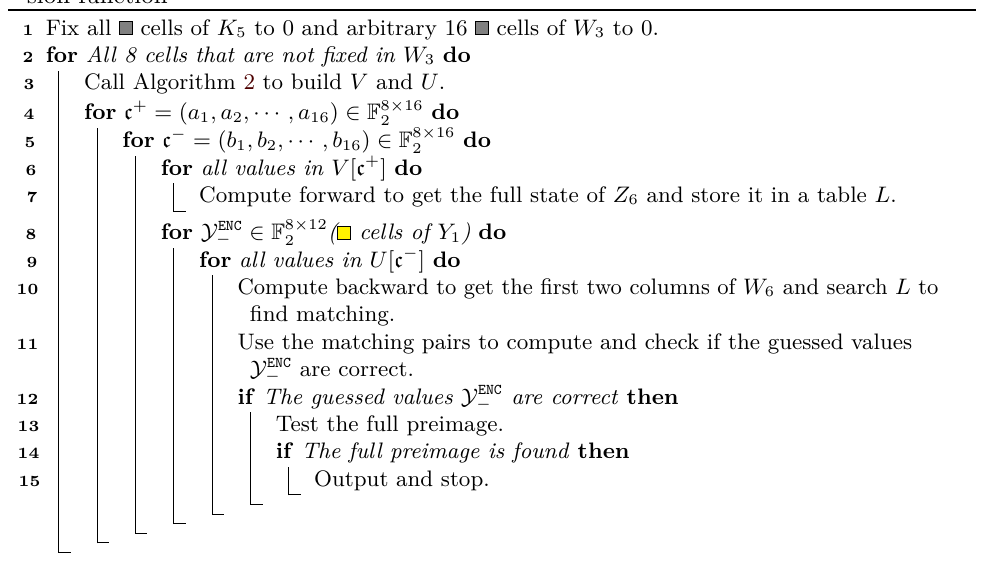
Algorithm 4: The MITM preimage attack on 8.5-round Streebog-512 compres- sion